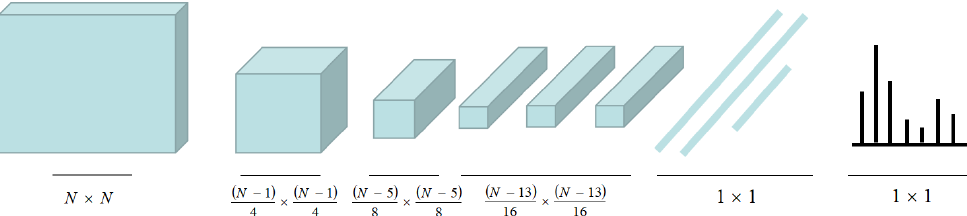
Figure 1. The size of the image input in convolutional neural network (CNN) is fixed N × N. After each pooling, the size of the feature map will become smaller accordingly. There are three 1 × 1 fully connected (FC) layers following a stack of convolutional layers. The prediction result is a 1D category probability information.